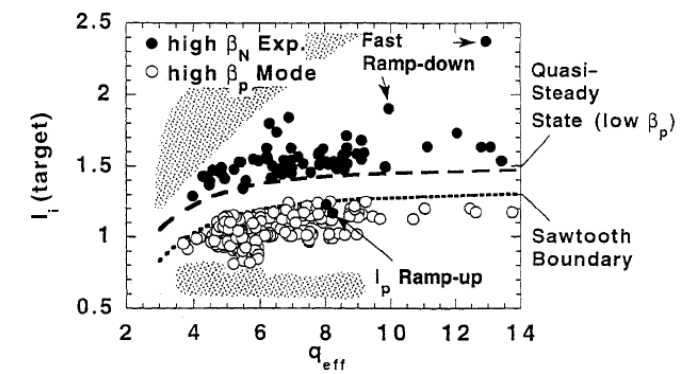
explored in the i ~0.8q . High  regime is characterized by eff 95 N